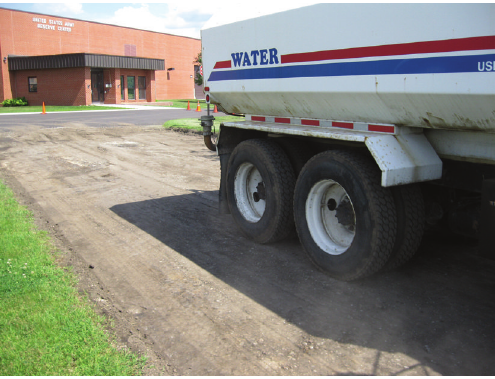
Figure 2: Photo showing typical proof rolling